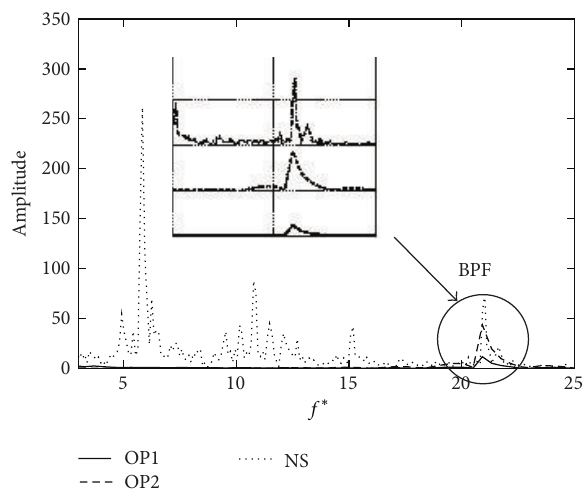
Figure 8: Frequency spectra of a pressure signal in the relative frame, at 90% span, at the impeller